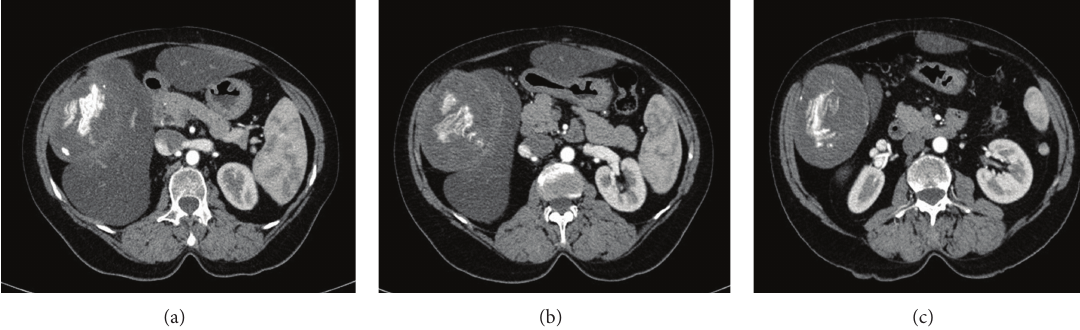
Figure 1: Gossypiboma seen at TC scan. There is an extra hepatic cystic mass with central calcifications.